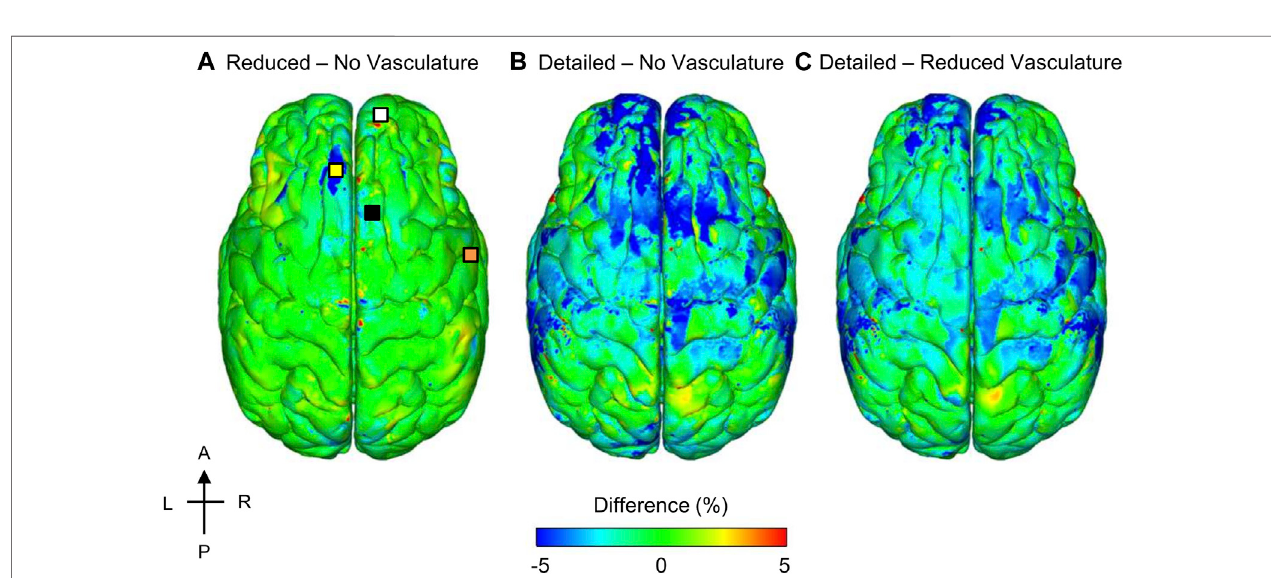
FIGURE 8 | Differences in the peak maximum principal strain (MPS) between models for the 104 kPa blast overpressure. Shown are the difference maps comparing the peak MPS between the reduced- and no-vasculature models (A) , between the detailed- and no-vasculature models (B) , and between the detailed- and reduced-vasculaturemodels (C) .Foreachpairofcomparisons,wecomputeddifferencesinmodelpredictionsby fi rstdeterminingthepeakMPSforeachmodelateach tetrahedralelementofthehumanbrainovertheblast-exposuresimulation time,andthensubtractingthem.Locations selectedforcomparison include:frontallobe (white square), longitudinal fi ssure (yellow square), parieto-frontal brain (black square), and temporal lobe (orange square) on the reduced – no vasculature difference map. A: anterior; P: posterior; R: right; L: left.